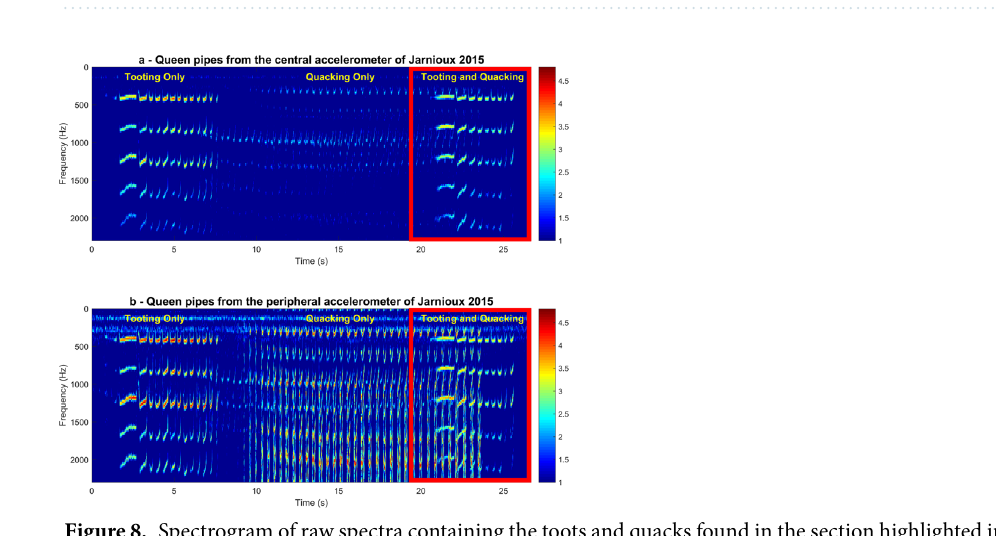
Figure 7. Continuous raw accelerometer data, averaged over three minute intervals, for frequencies between 0 and 1000 Hz, recorded from a single colony in Jarnioux, France, on 30 th April 2015. Data are shown for the accelerometers situated at the centre ( a ) and at the periphery ( b ) of the frame. Data shown were recorded on the 30 April 2015. Colour coding represents logarithmic spectral amplitude from low (blue) to high (red) in arbitrary units. Highlighted in the black rectangle is the short sample of data that is represented in Fig. 8. This figure was created using the MATLAB (R2018b) software (uk.mathworks.com).